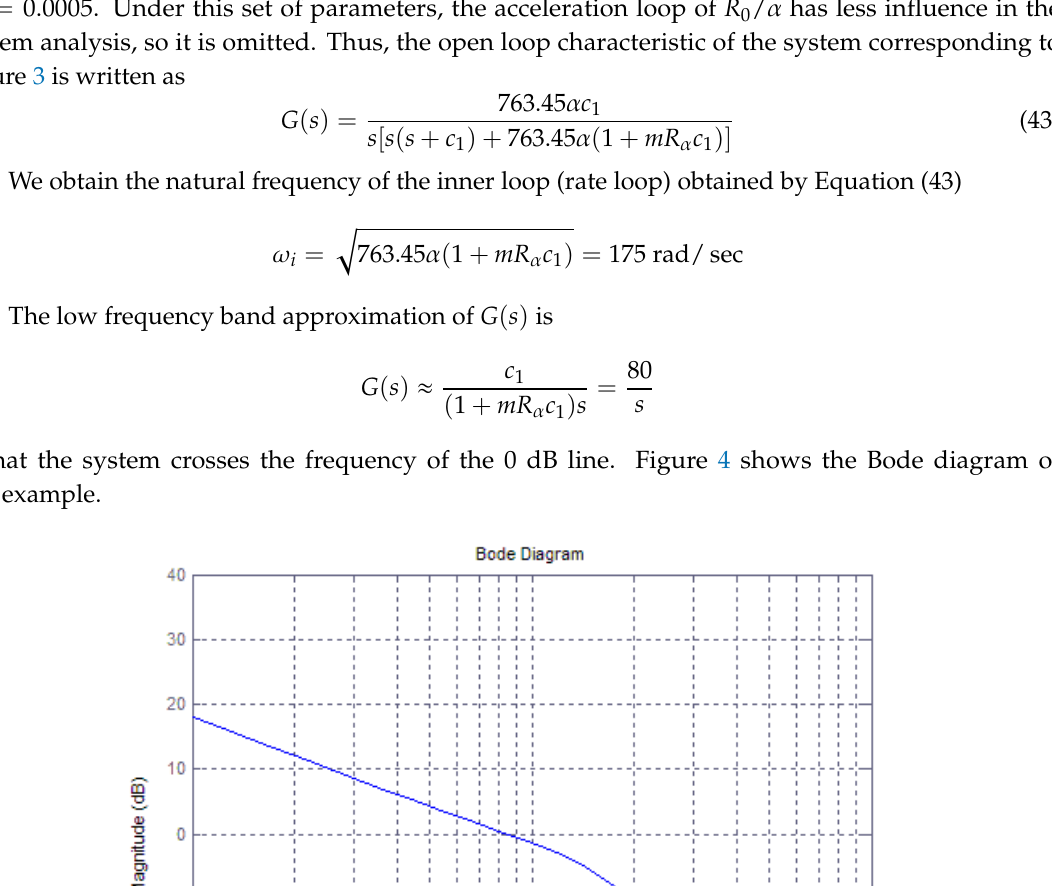
Figure 3. Signal-flow diagram of the (PBC) system.